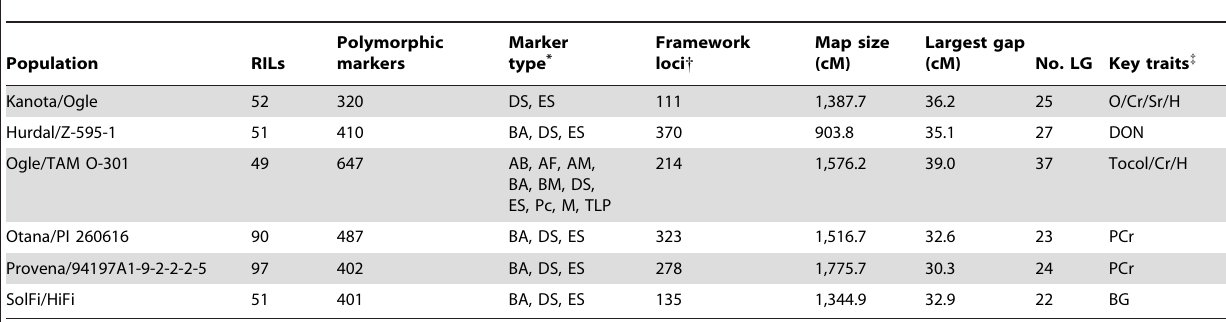
Table 2. Population size, marker statistics, map characteristics, and key traits for RIL populations used for consensus mapping.